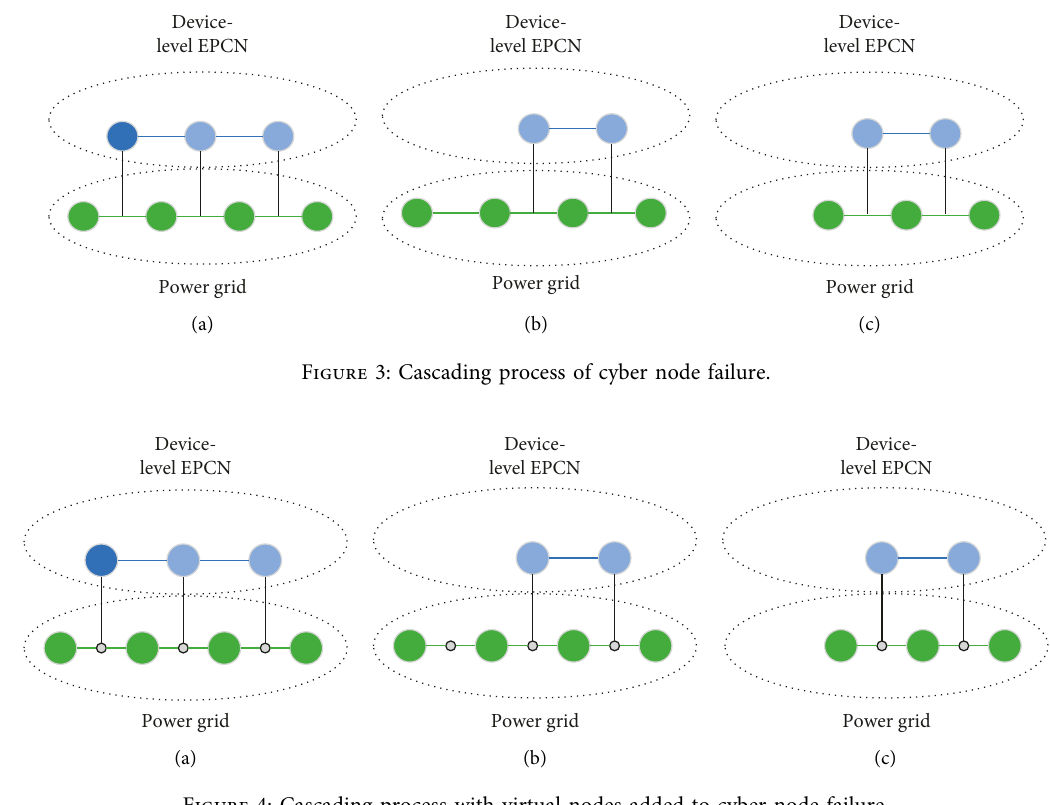
Figure 4: Cascading process with virtual nodes added to cyber node failure.